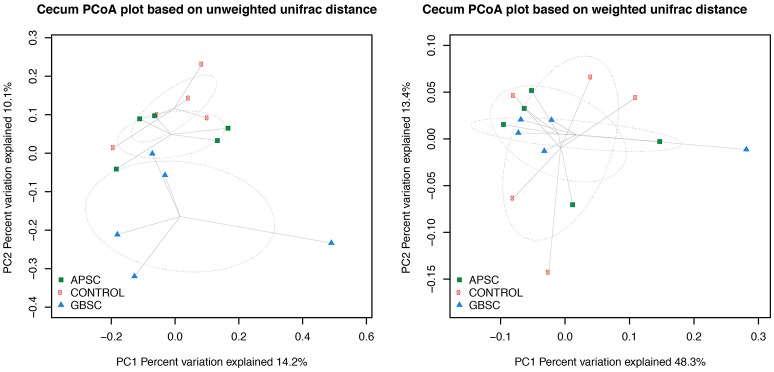
Two-dimensional PCoA plots based on the unweighted and weighted UniFrac distance matrix illustrates variation in cecal bacterial communities as affected by different subacute ruminal acidosis (SARA) challenge conditions. The ellipses were drawn with standard errors of the points at 0.95 confidence limit. Labels are placed at means centers of each site and are linked to each sample of the corresponding site. Abbreviations in figure: APSC, alfalfa-pellet SARA challenge; GBSC, grain-based SARA challenge. Significance levels unweighted analysis, APSC vs. Control P = 0.53; GBSC vs. Control P = 0.05; GBSC vs. APSC P = 0.26. Significance levels weighted analysis, APSC vs. Control P = 0.75; GBSC vs. Control P = 0.56; GBSC vs. APSC P = 0.77.